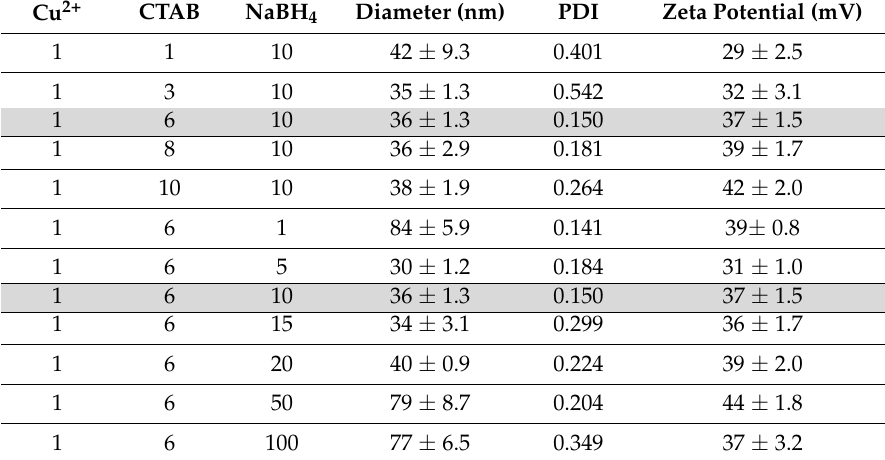
Table 1. Hydrodynamic diameter, polydispersity index, and Zeta potential, determined by Dynamic Light Scattering (DLS) measurements of samples that are prepared at different molar ratios of Cu 2+ :CTAB:NaBH 4